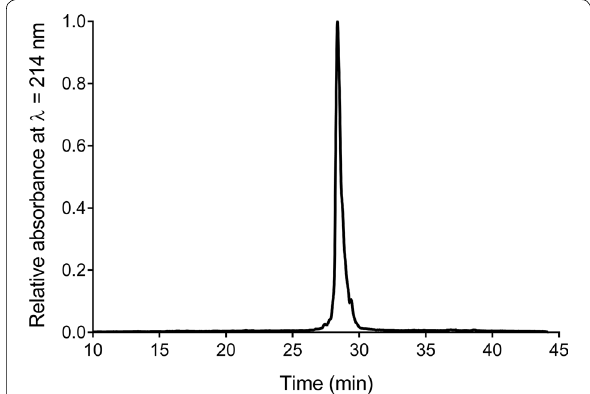
Fig. 5 Characterization of DAMP4 var ‑pexiganan protein after the purification process as determined by using